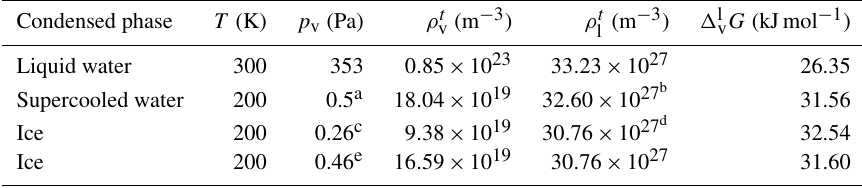
Table C1. Estimates of the free energy of transfer based on experimental